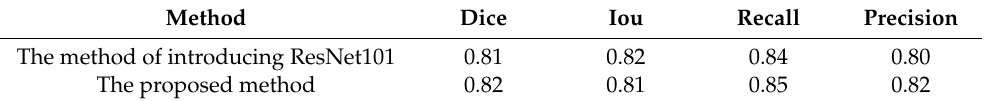
Table 7. Influence of layer 5 network with ResNet34 and ResNet101 on model segmentation capability.